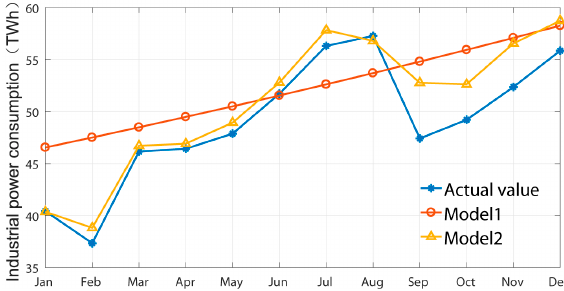
Figure 5. Comparison the simulation results with the actual values in 2006. Table 4. Precision index of Models 1 and 2 in 2006 year.